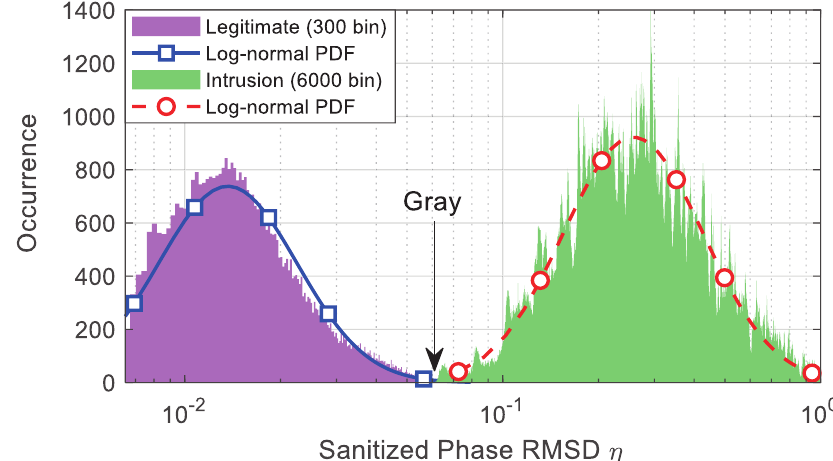
Figure 7. Histogram of sanitized phase RMSD η .